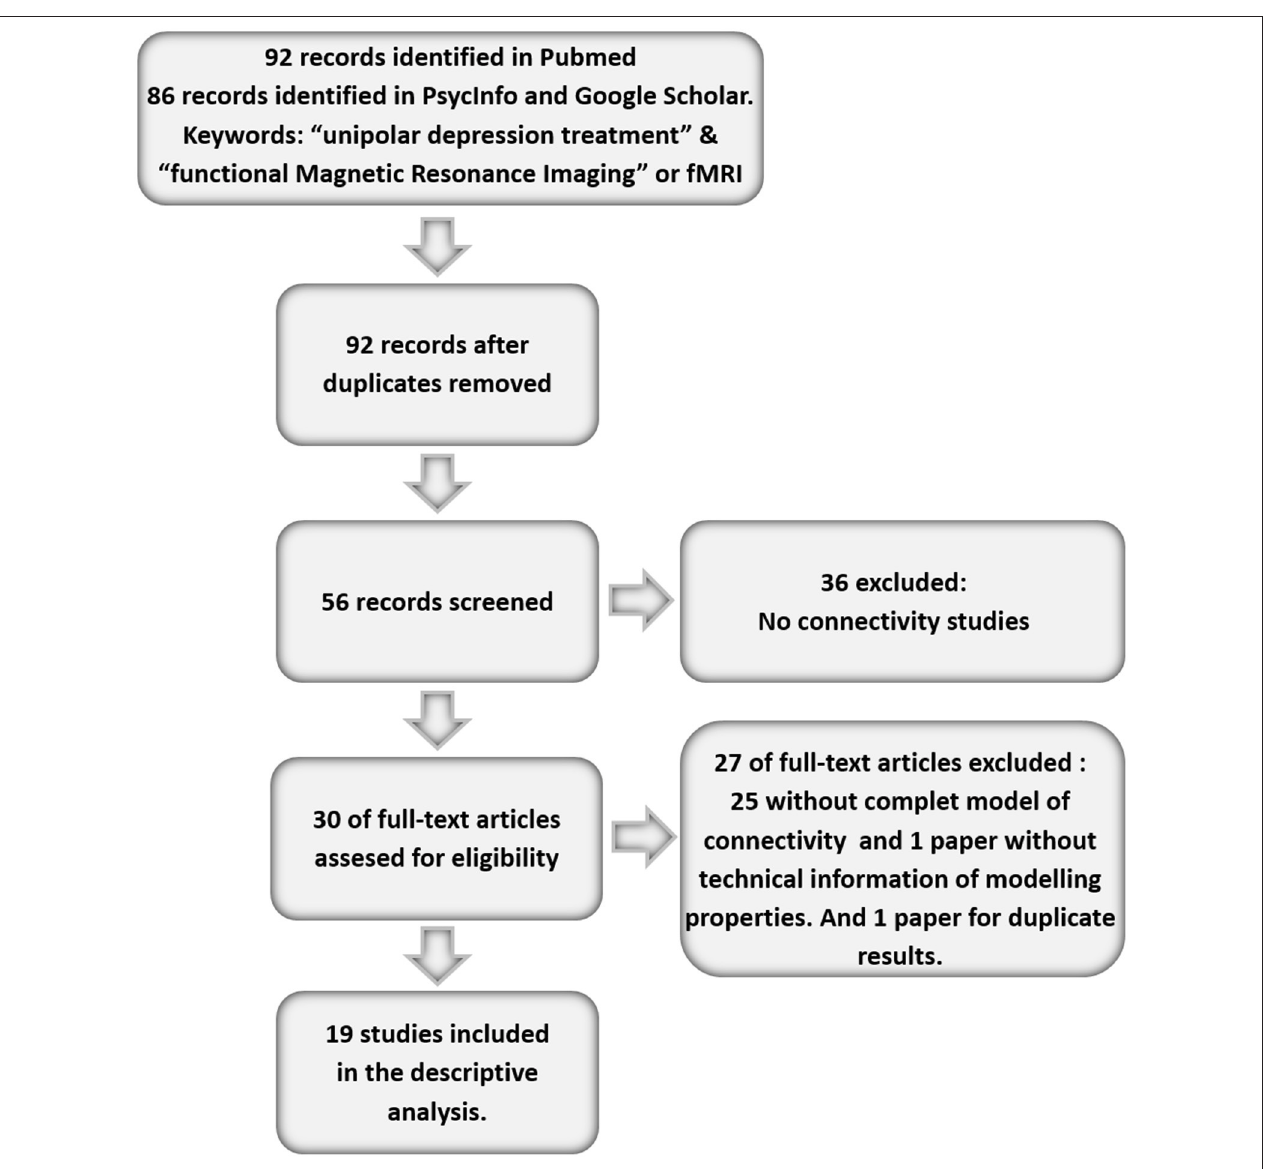
FIGURE 1 | Flow chart of the paper selection